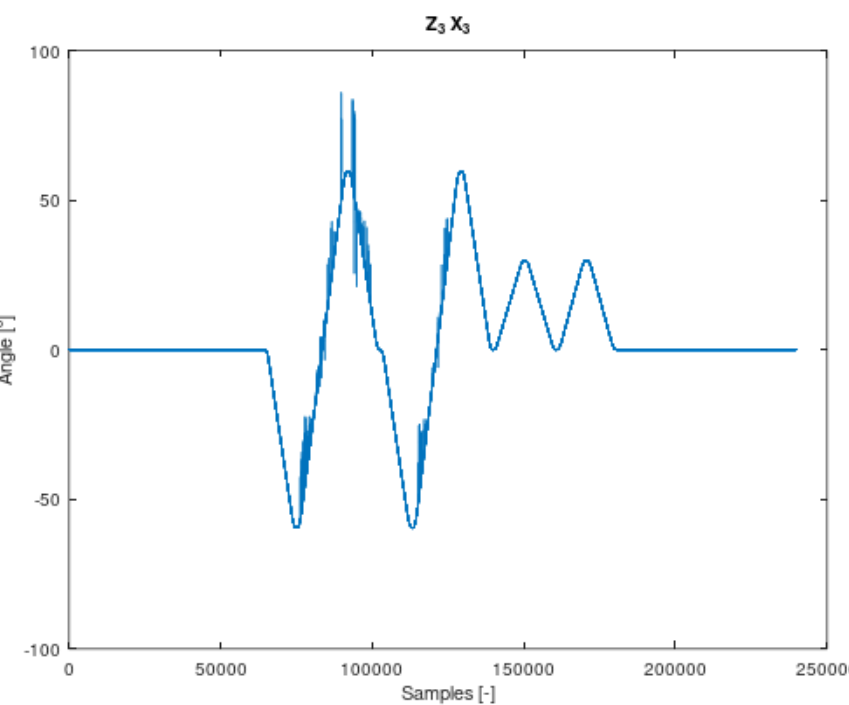
Figure 5. The angle set on the robot axis to which the coordinate system is assigned 𝑧 2 𝑥 2 in Figure 3. Data from FANUC robot encoders collected using the apparatus.